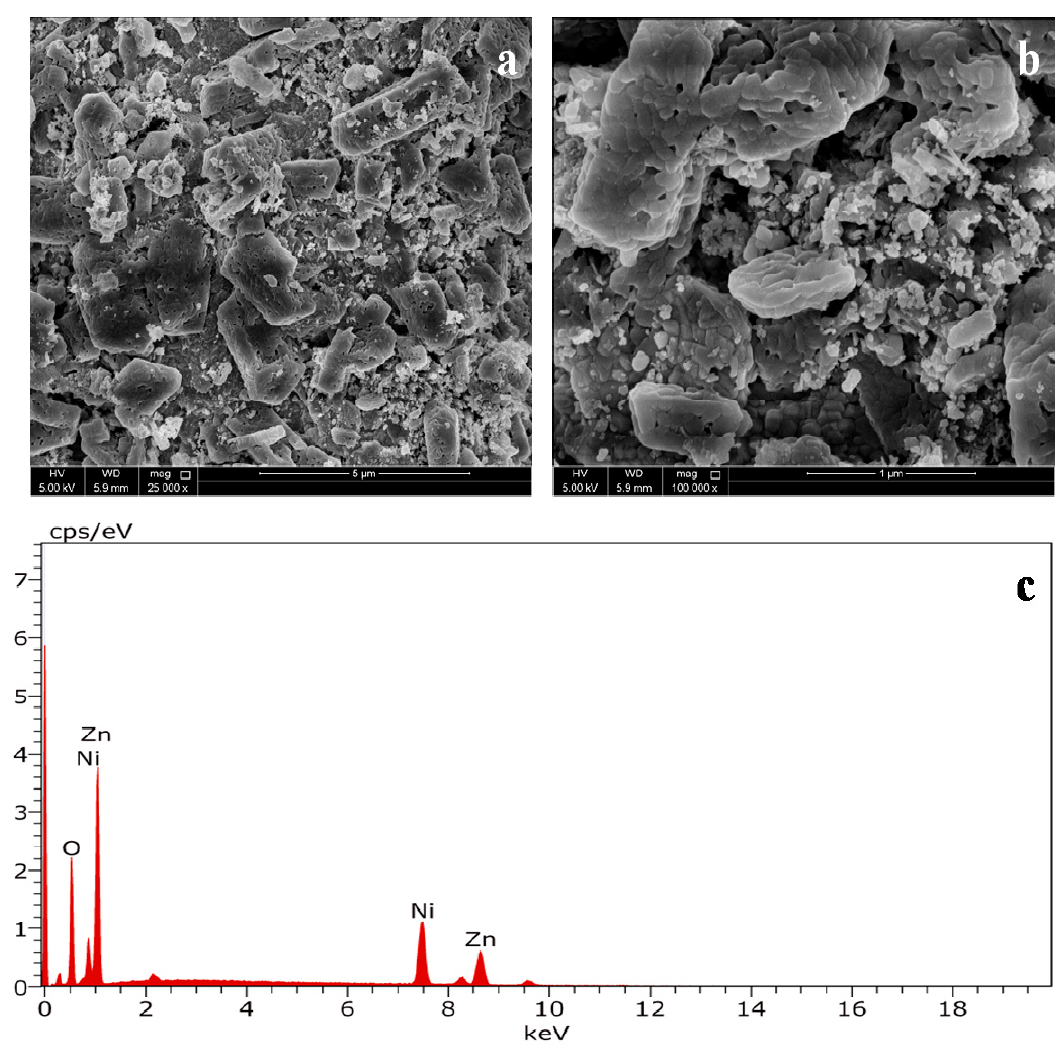
Figure 2. ( a , b ) SEM with different magnifications and ( c ) Energy Dispersive Absorption X-ray (EDAX) images of ZnO-NiO nanocomposite.